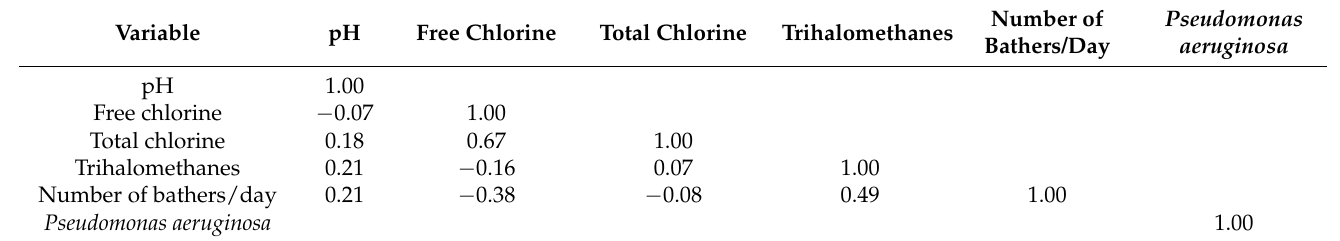
Table 3. Coefficients of correlation between chemical parameters, the number of bathers per day, and Pseudomonas aeruginosa bacteria levels of analyzed pool waters with the disinfection method of UV radiation with chlorination (UV + Cl) represented by nonparametric Kendall-Tau correlation tests (N = 504; 126 samples × four sampling points). Statistically significant correlations ( p < 0.05) are presented in bold-type